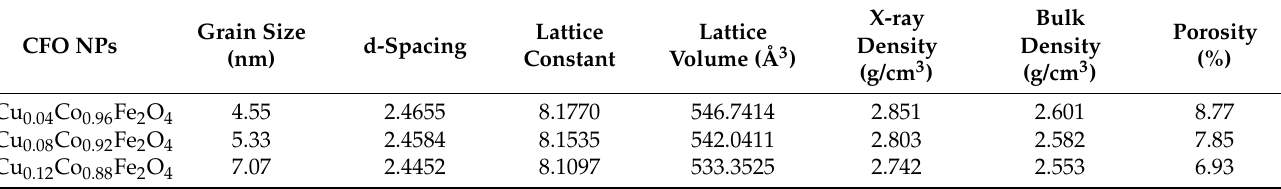
Table 1. Structural properties of CFO NPs doped with Cu 2+